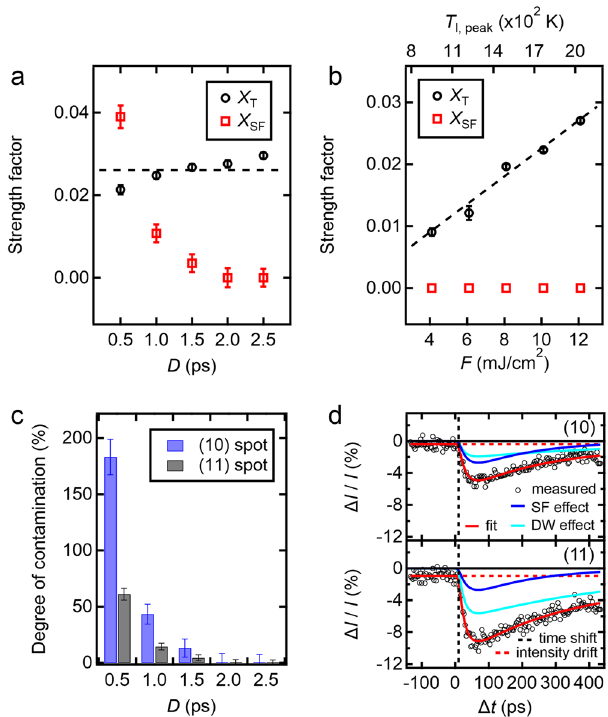
Fig. 3 Quantitative analysis of the diffracted beam intensity. a D -dependence of X T , and X SF , the overall scale factors of the temperature excursion and the surface fi eld effect after photo-excitation, for a fi xed F of 12.2 mJ cm − 2 . Black circle and red box indicate X T and X SF , respectively. The black dashed line is the weighted average of X T . b F -dependence of X T and X fi xed D of 2.0 ps. The black dashed line is a weighted linear fi t of X SF for a through (0,0). The upper horizontal axis indicates the calculated peak lattice temperature, T l,peak , of graphene. The error bars in a , b correspond to ±1 standard deviation of the fi tting results. c Degree of the surface fi eld effect contamination as a function of D for the (10) (blue bar) and (11) re fl ections (gray bar) for a fi xed F of 12.2 mJ cm − 2 . The error bars in c indicate calculated uncertainties from the error propagation analysis for the combination of independent errors of the extracted X T and X SF . d Separation of the surface fi eld effect and the Debye – Waller effect for F = 12.2 mJ cm − 2 and D = 0.5 ps. Black circles are the measured Δ I / I as a function of Δ t for the (10) (upper panel) and the (11) (bottom panel) re fl ections. The solid red curves are the results of a simultaneous fi t of both time traces. Solid blue and cyan curves indicate the individual contributions of the surface fi eld and Debye-Waller effect, respectively. Dotted red and black lines correspond to the corrections applied for intensity drift and time zero